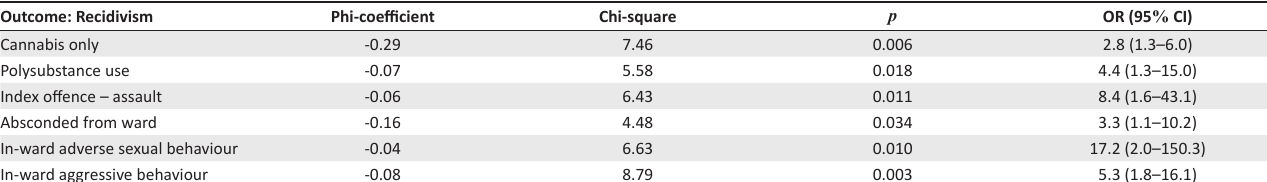
FIGURE 2: Percentage of recidivist patients ( n = TABLE 4: Results of multiple logistic regression analysis. Outcome: Recidivism